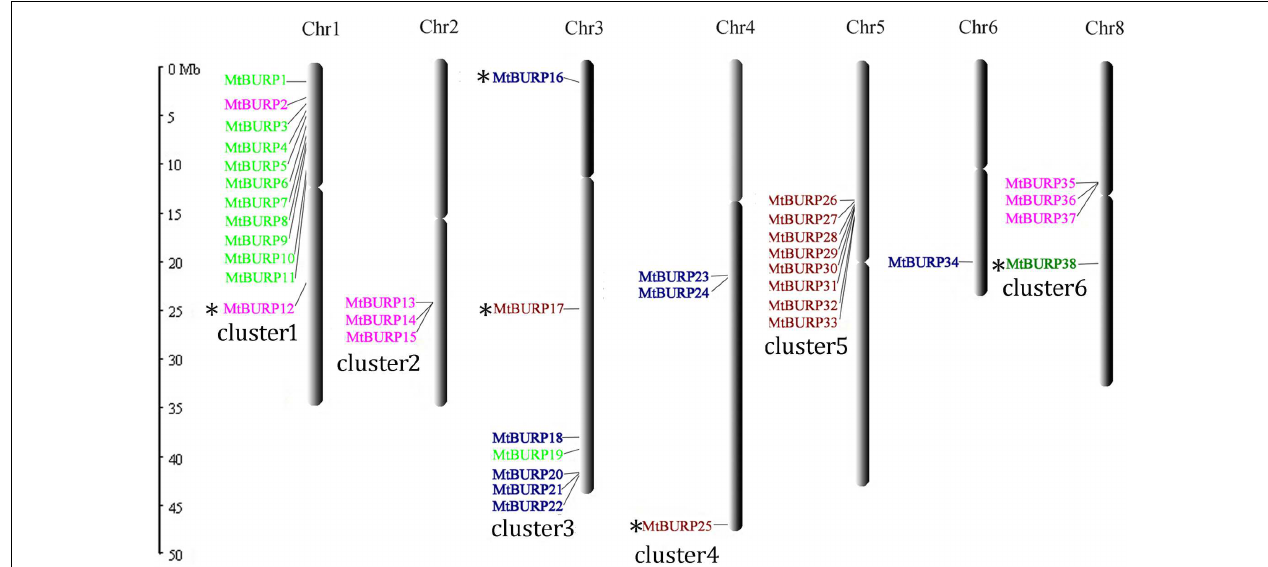
FIGURE 1 | Physical locations of MtBURP genes on Medicago truncatula chromosomes. Gene names in different subfamilies are highlighted with various colors. And these colors were corresponding to the results in Figure 2 , which represent different subfamilies. All BURP genes distributed in different chromosomes belong to cluster1–6 except chromosome 6. The “ ∗ ”represent that these genes were no clustered together with each